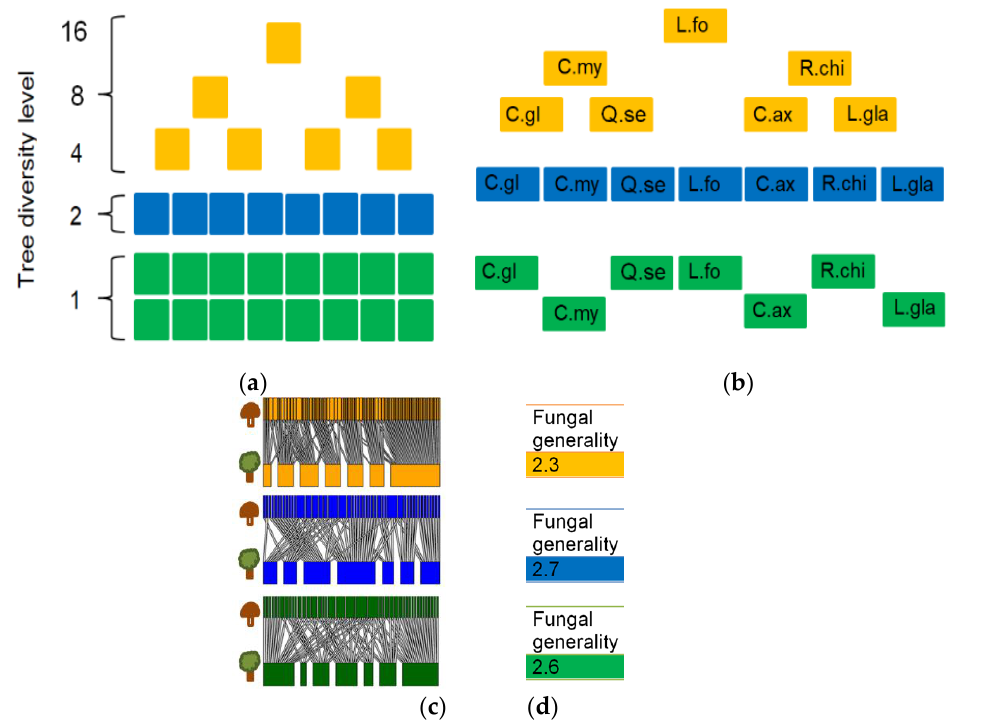
Figure 1. The bipartite network analysis procedure. Data were pooled into three tree diversity levels ( a ). An illustrative subsampling set ( b ). For each subsampling combination, a bipartite network was generated ( c ) and network characteristics such as fungal generality were computed ( d ). Statistical di ff erences between the tree diversity levels could be analyzed by considering the combined network characteristics of 576 possible subsampling combinations at each tree species diversity level. According to Almeida-Neto , et al. [73] the nestedness metric Nestedness metric based on Overlap and Decreasing Fill (NODF) is more robust than the nested temperature metric; higher NODF values indicate greater nestedness. NODF values of our data were statistically compared them to NODF values generated using a simulated null model. The null model was created by shu ffl ing the OTU abundance data before it was divided into subsets corresponding to di ff erent tree diversity levels. The column and row sums of the data were kept constant during shu ffl ing. We then used the nullmodel function of the vegan package with the “r2dtable” method to create the null